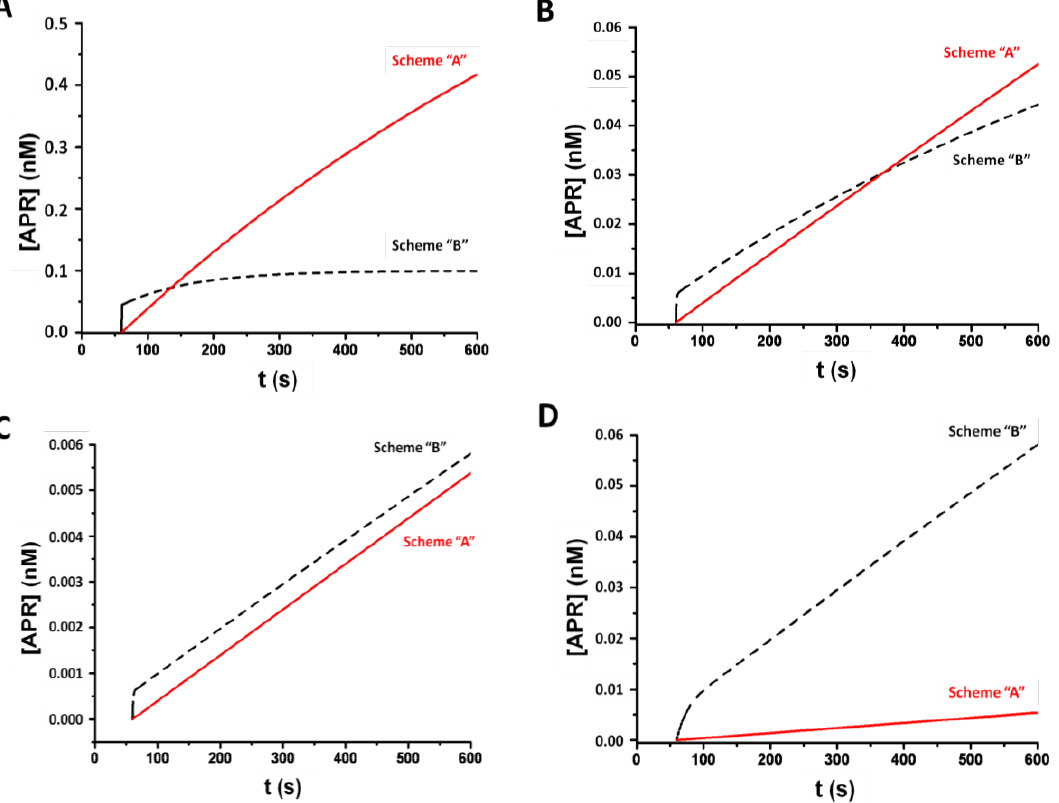
Figure 3. Kinetics of the APR formation in schemes A and B of the ICA; the model parameters are as follows: [A] 0 = 10 − 5 M, [P] 0 = 10 − 7 M, x = 10 − 4 ; t–t 1 = 60 s. ( A ) k a1–4 = 10 6 M − 1 · s − 1 , [R] 0 = 10 − 6 M; ( B ) k a1 − 4 = 10 5 M − 1 · s − 1 , [R] 0 = 10 − 6 M; ( C ) k a1–4 = 10 4 M − 1 · s − 1 , [R] 0 = 10 − 6